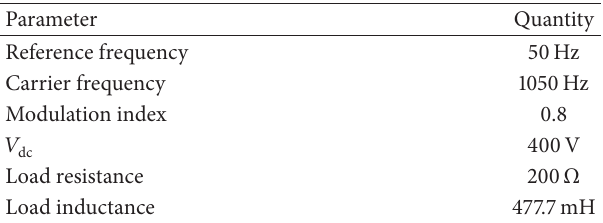
Table 5: Simulation